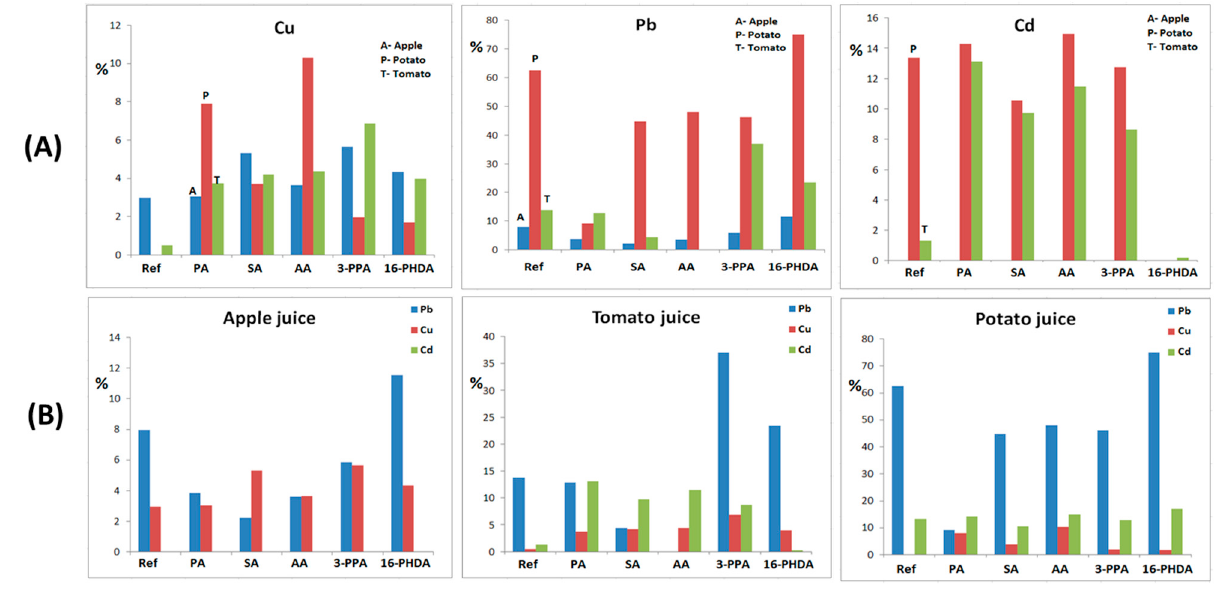
Figure 5. Graphical presentation of FAAS data: ( A ) juice dependence, ( B ) element dependence